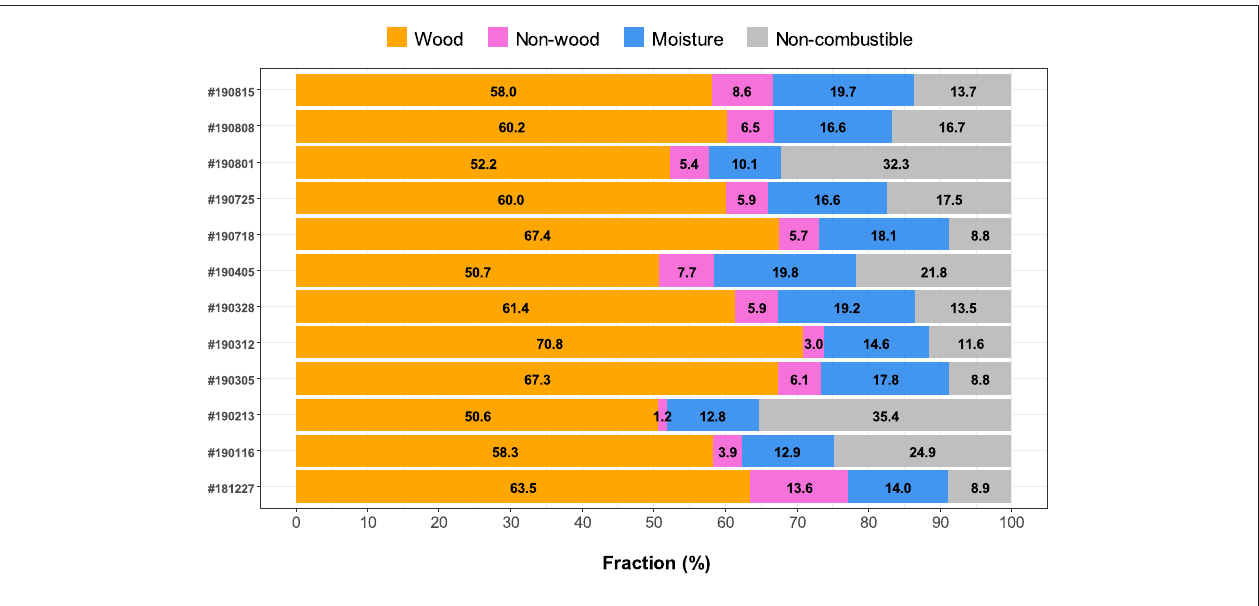
FIGURE 2 | Material fractions of CDWDF from PVT Land